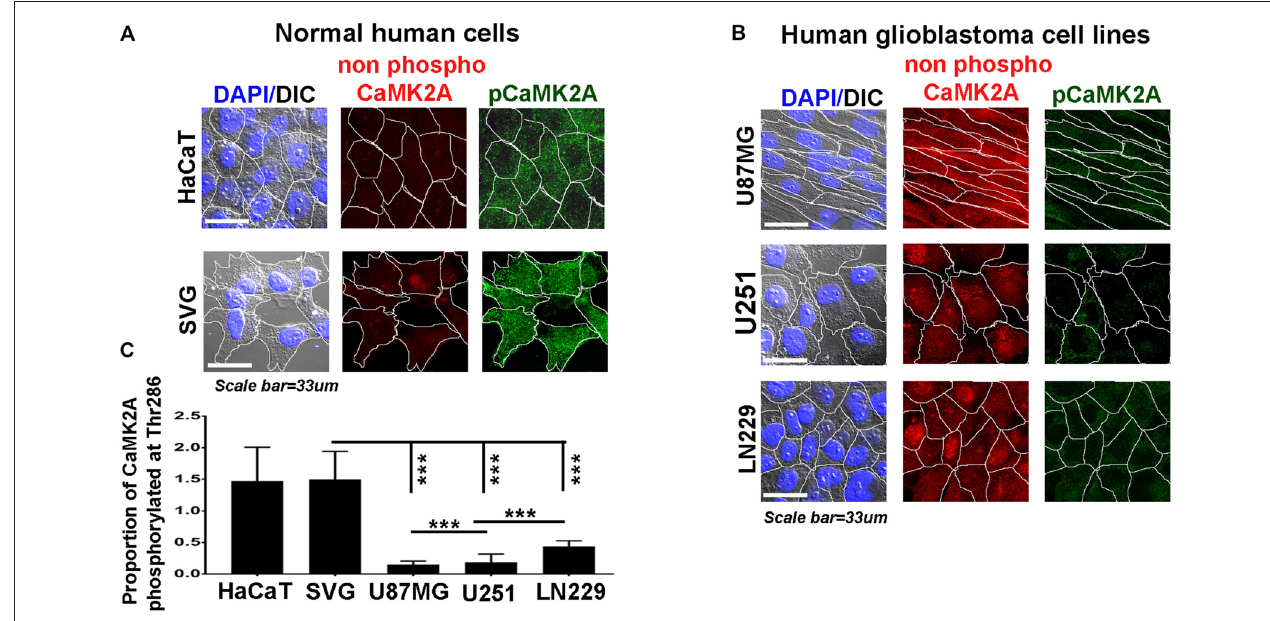
FIGURE 3 | Levels of CaMK2A phosphorylation at T286 is lower than non-phospho CaMK2A in aggressive GBM tumor cell lines vs. normal cells. Single cell quantitative image analysis procedure (see John et al., 2017) was employed to measure non-phospho CaMK2A and pCaMK2A T286 protein levels in (A) normal human cells: SVG-subventricular zone derived glial cells; HaCaT-epidermal keratinocytes and (B) various GBM patient derived tumor cell lines: U87MG, U251 and LN229. (C) The proportion of phosphorylated CaMK2A determined by normalizing average signal of phospho CaMK2A T286 (obtained from over 200 cells in five random fields, per three independent experiments) to average signal from non-phospho CaMK2A showed higher levels in normal cells and significantly lower levels in GBM cell lines. The results corroborate well with the observation on GBM patient tissue array. The analysis is representative of three independent experiments. ∗∗∗ p < 0.001. Error bar =